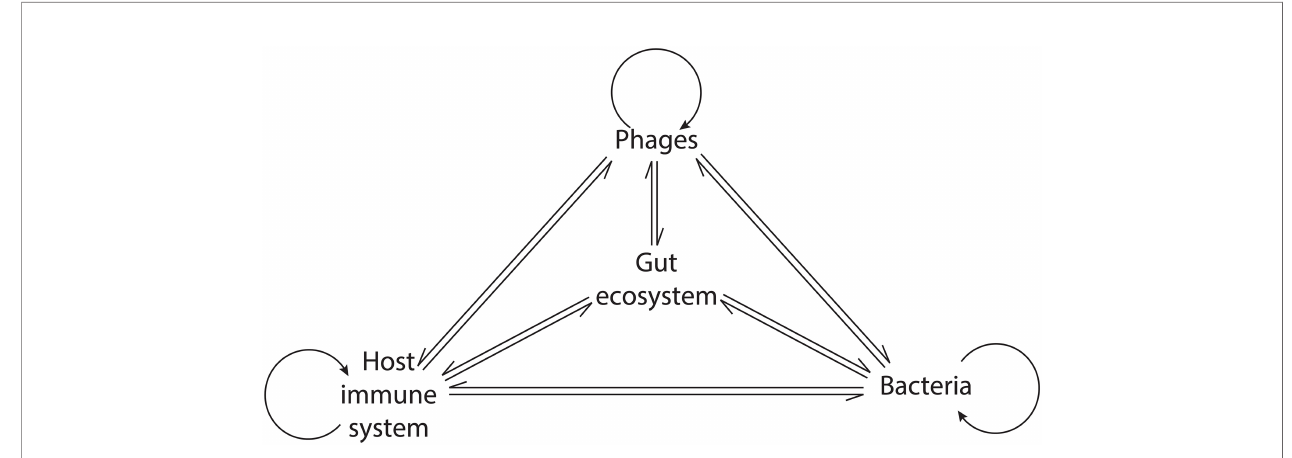
FIGURE 2 | Network of the phage interactions in the gut ecosystem. Phages exert a direct in fl uence on bacteria, the host immune system, and themselves. Indirectly, their activity modulates the interaction within bacterial communities and between bacteria and the host immune system, leading to cascading ecosystem